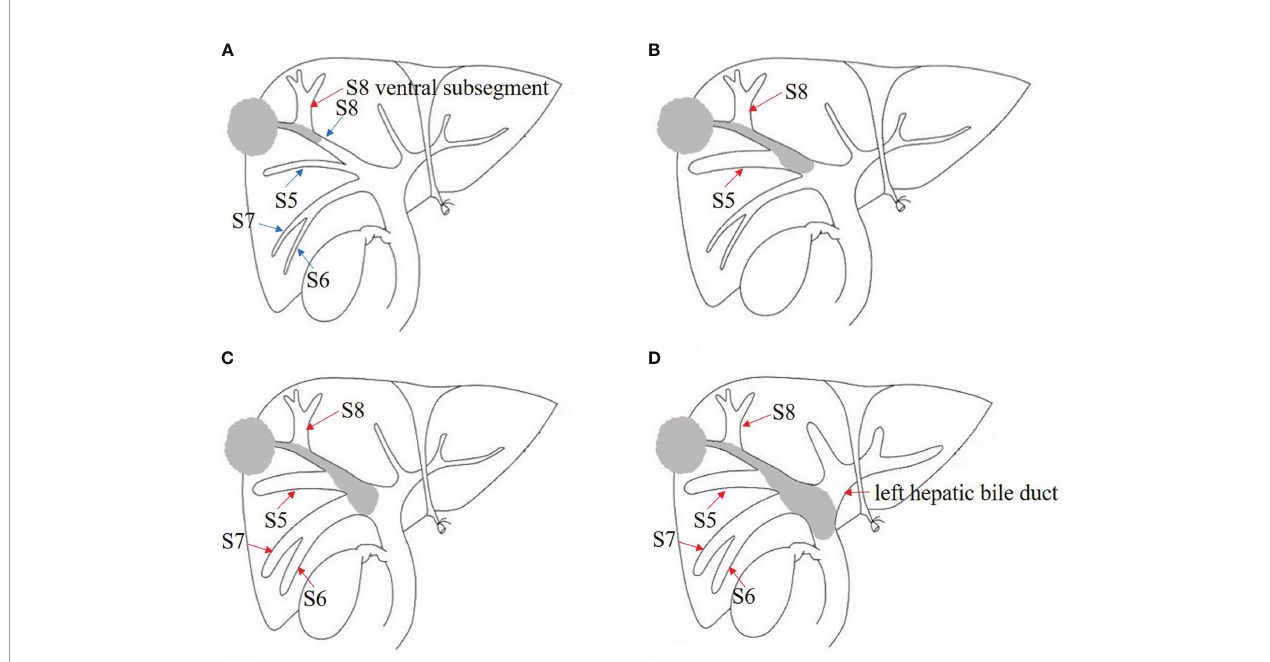
FIGURE 1 | Japanese classi fi cation of BDTT. (A) B1: The tumor locates in S8 and the tumor thrombus invades the con fl uence of dorsal and ventral bile ducts; the bile duct dilation of ventral subsegment is observed. (B) B2: As the tumor thrombus further extends to the con fl uence of S5 and S8, bile duct dilation of S5 can be seen. (C) B3: The tumor thrombus extends to the right hepatic duct, and the bile duct dilation of the right posterior lobe can also be seen. (D) B4: The tumor thrombus extends to the common bile duct, and the bile duct dilation of left hepatic lobe can be seen. The bile duct dilation was marked with the red